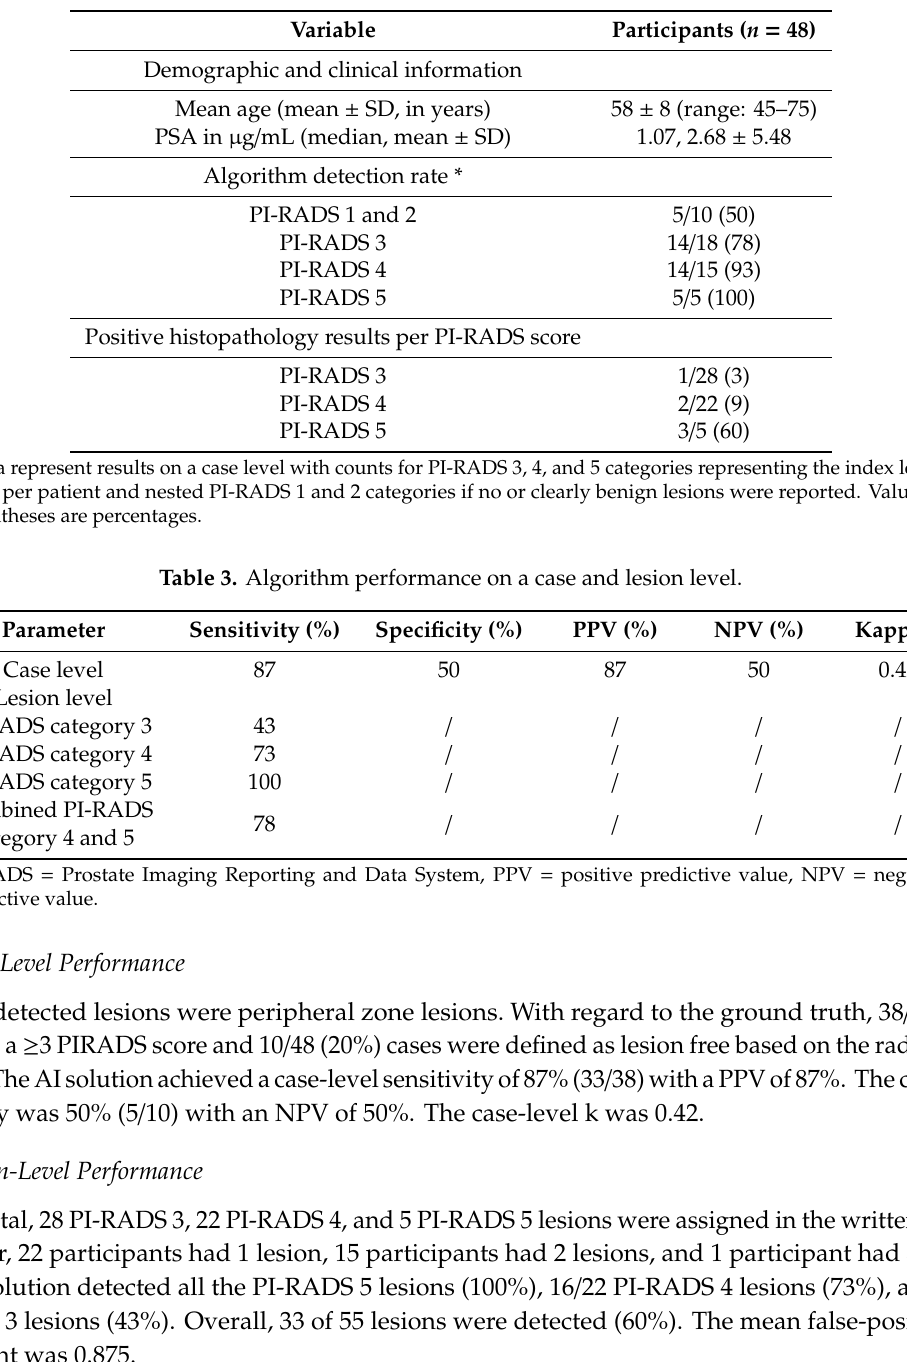
Table 2. Demographic and clinical information. PI-RADS = Prostate Imaging Reporting and Data System, PSA = prostate-specific antigen.